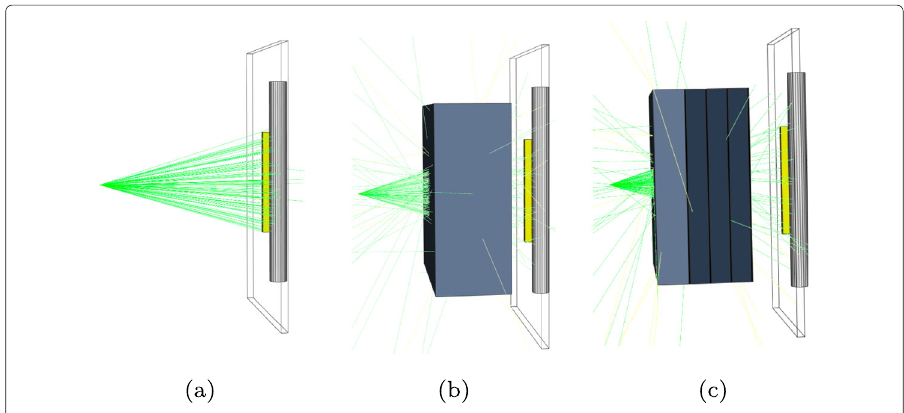
Fig. 3 Simulated geometry of configurations (FastN) ( a ), (ThermN) ( b ) with the polyethylene brick and (BackgN) ( c ) with the polyethylene brick and the alternate lead and borated polyethylene slabs in black and dark blue respectively. The detector appears in gray. The wireframe volume acts as the neutron shielding used in the experimental set-up. The yellow window lets the neutrons into the detector active area. Generated neutrons are depicted in